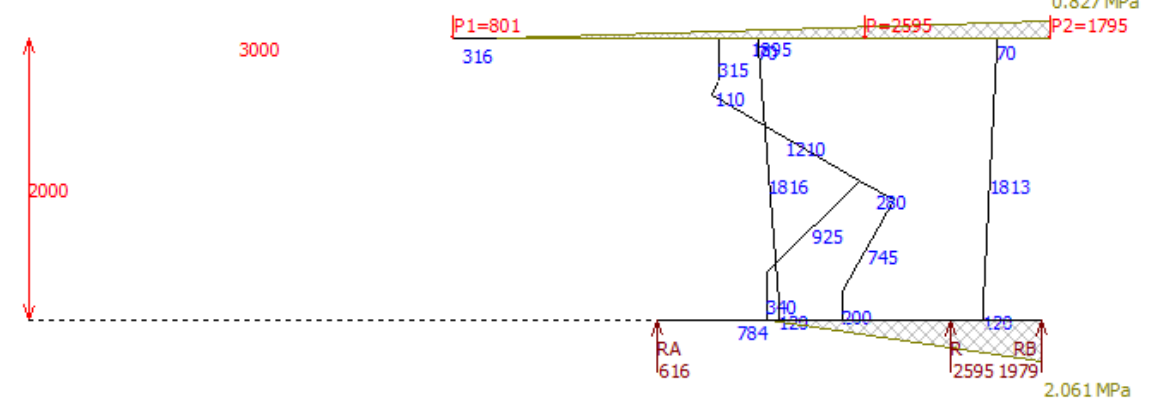
Figure 11: The value and distribution of the load-bearing capacity of the powered roof support with pressure of 32 MPa set in the hydraulic legs for an operating height of 2